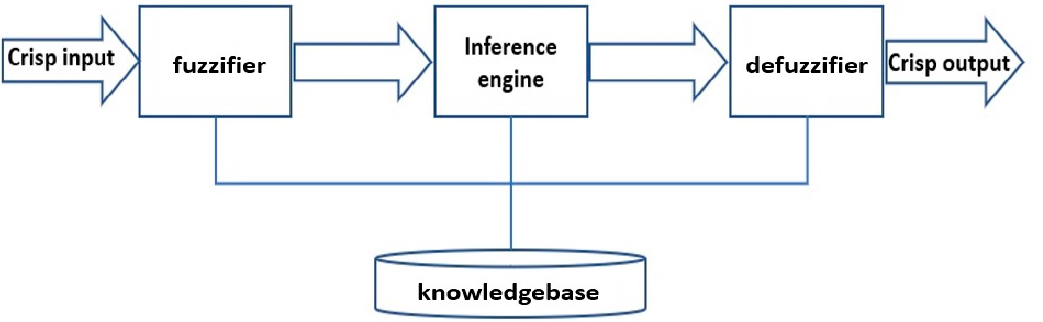
Figure 6. Fuzzy inference system architecture.